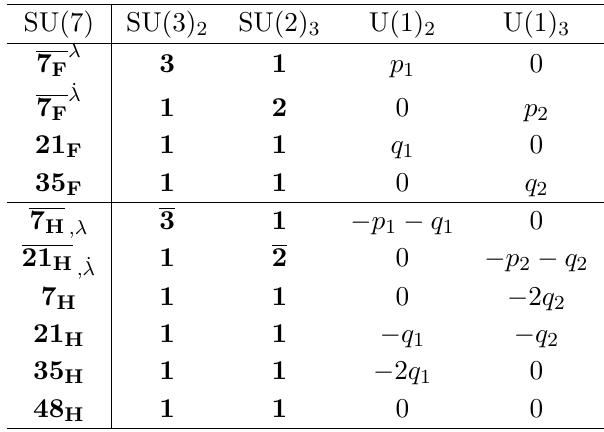
Table 6 . The SU(7) fermions and Higgs representations under the global DRS symmetry in eq.